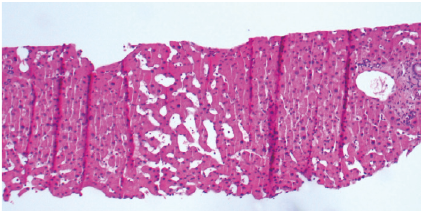
Figure 1: (H&E, 100x) needle core biopsy of hepatic parenchyma demonstrating central vein and sinusoidal dilatation.